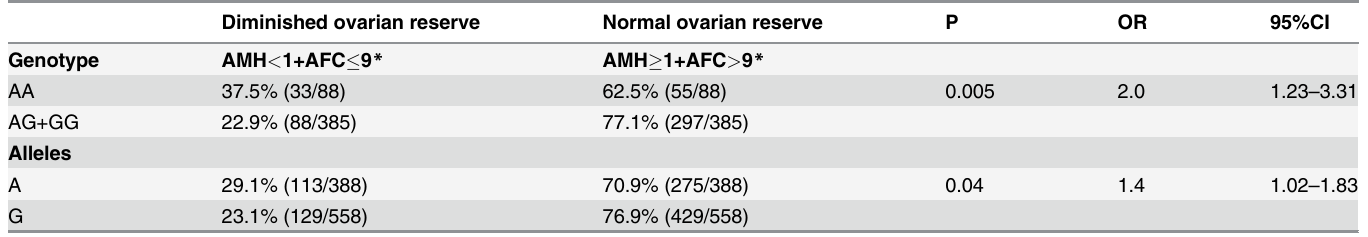
Table 4. Genotypes and alleles frequencies distribution in diminished and normal ovarian reserve groups. Diminished ovarian reserve Normal ovarian reserve P OR